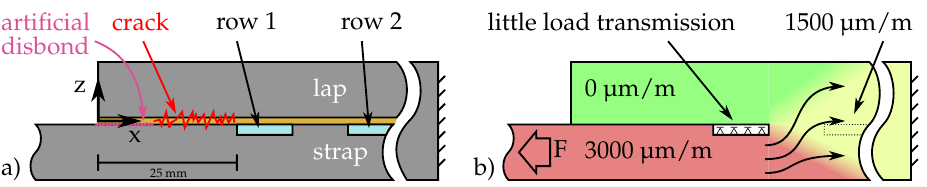
Figure 5. Simplified mechanical model of sensor zone: ( a ) specimen sideview with exaggerated crack depiction and inlay colored in light blue and ( b ) force transition flow into the overlapping adherend, indicated by arrows. The red (full load) to green (no load) color transition indicates the approximate stress. Little load is transferred at the polymer strip interface due to the low PVDF stiffness.